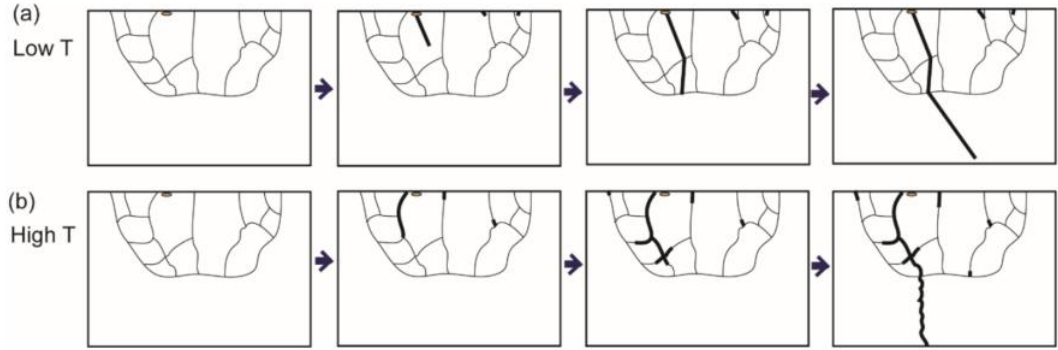
Figure 12. Schematic fatigue fracture modes of the partially recrystallized single crystal superalloy at di ff erent temperatures; ( a ) lower temperature, below T E , e.g., 550 ◦ C; ( b ) higher temperature, above T E , e.g., 850 ◦